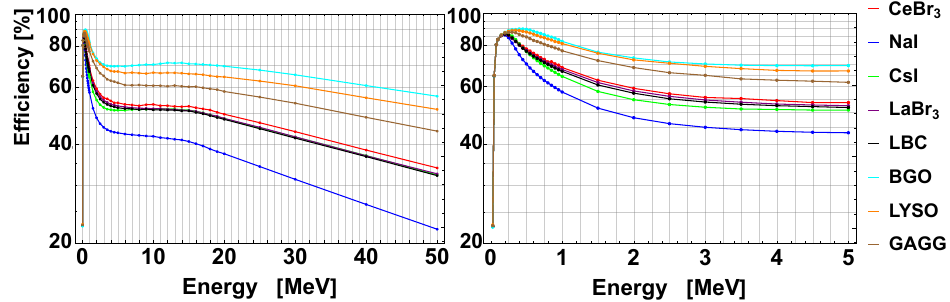
Figure 5. Detection efficiency of the reference instrument as a function of the gamma-ray energy for several crystals normalized to the same volume (each crystal has 23 × 23 × 45 mm 3 of dimensions), encapsulated in the same aluminum enclosure and presented at two different energy